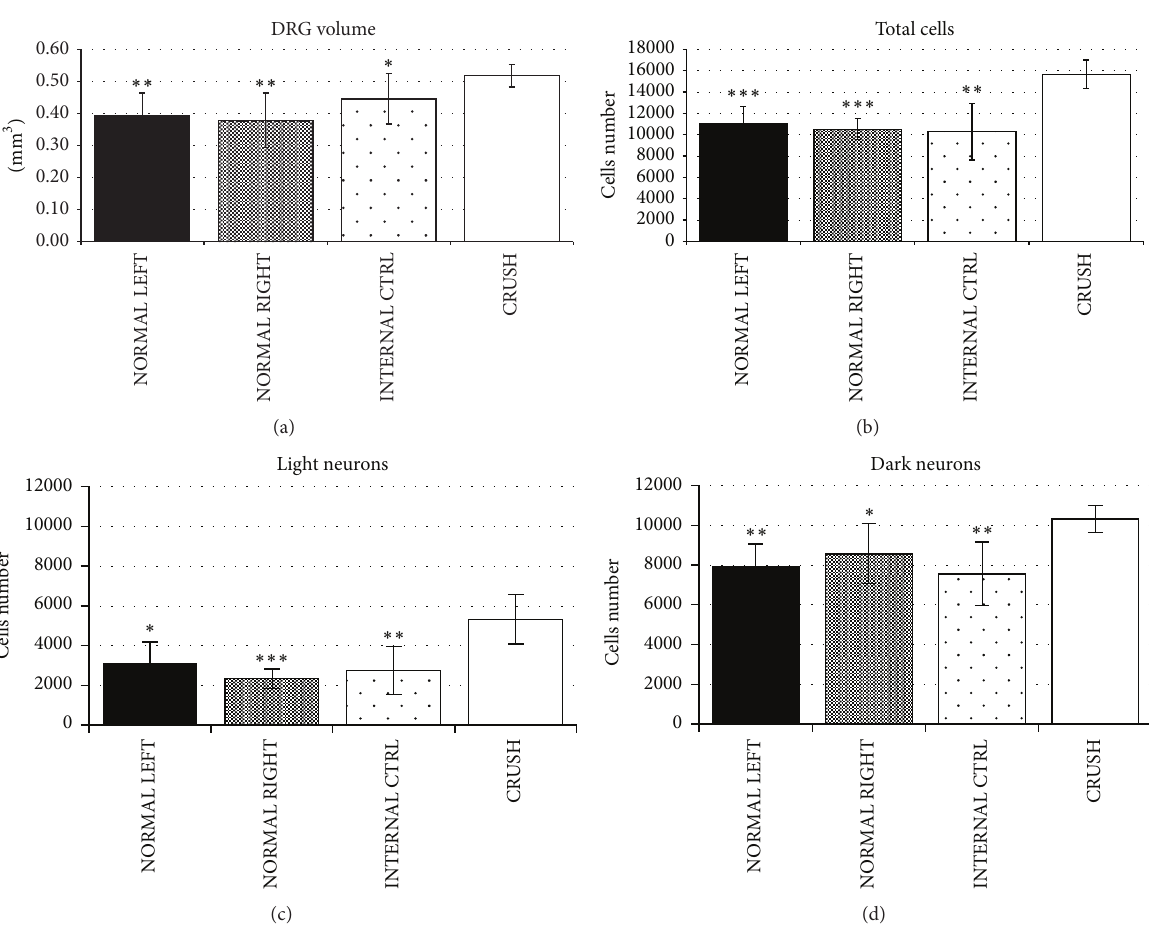
Figure 3: (a) T1s affected by crush lesion showed an evident hypertrophy compared to controls. (b) Physical disector stereological analysis was applied to T1s ganglia. The overpopulation of neurons was distributed among the light and large neurons (c-d). The data were analyzed using both ANOVA and 𝑡 -test analyses. ∗ 𝑃 ≤ 0.05 ; ∗∗ 𝑃 ≤ 0.01 ; ∗∗∗ 𝑃 ≤ 0.001 versus CRUSH group.